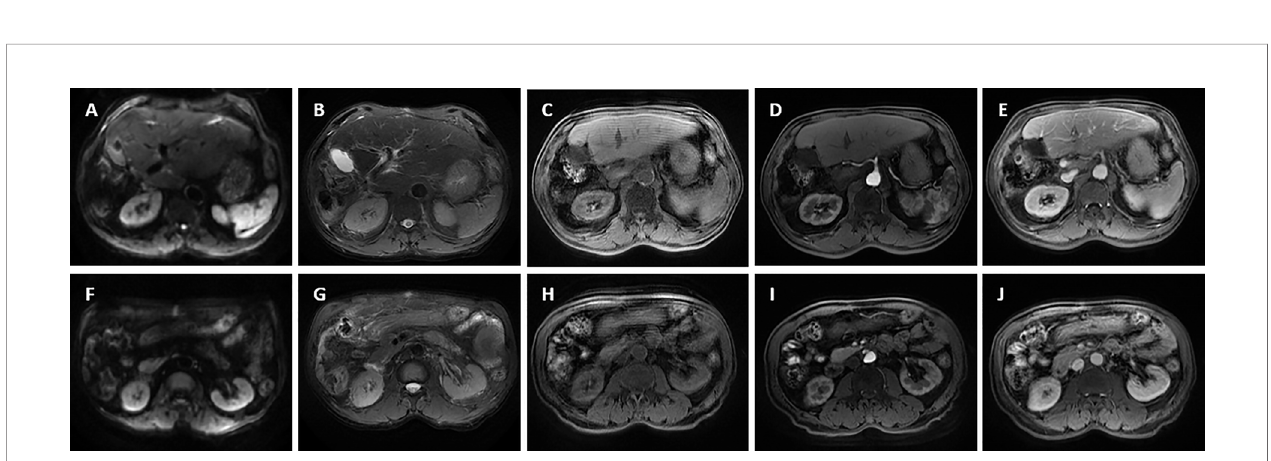
FIGURE 8 | Magnetic resonance imaging was performed for the patient 1 month after surgery. It revealed postoperative changes of liver and gallbladder, a little exudation and effusion in the operative area. (A, F) Diffusion-weighted imaging (DWI); (B, G) T2-weighted imaging; (C, H) T1-weighted imaging; (D, I) The arterial phase; (E, J) The delayed phase.